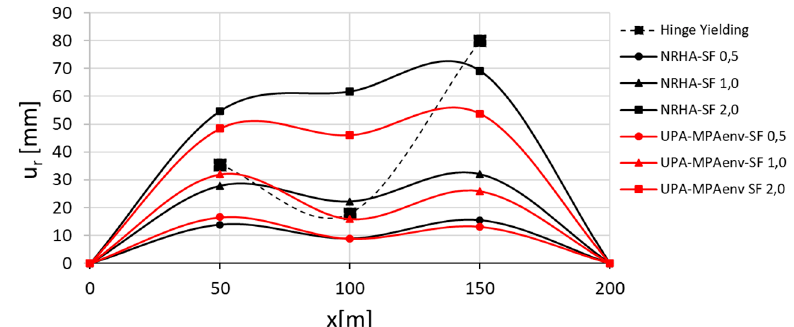
Figure 16. Fault normal: displacements of the deck derived performing NRHA and IMPA β (scale factor from 0.5 g to 2.0 g).